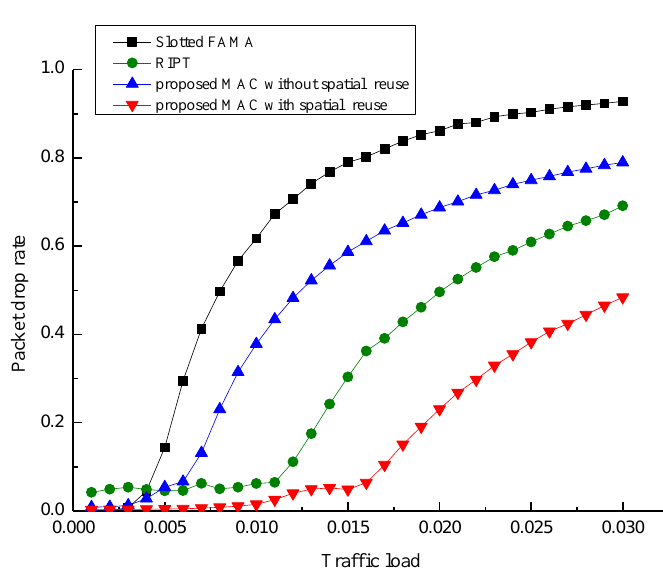
Figure 11. Packet drop